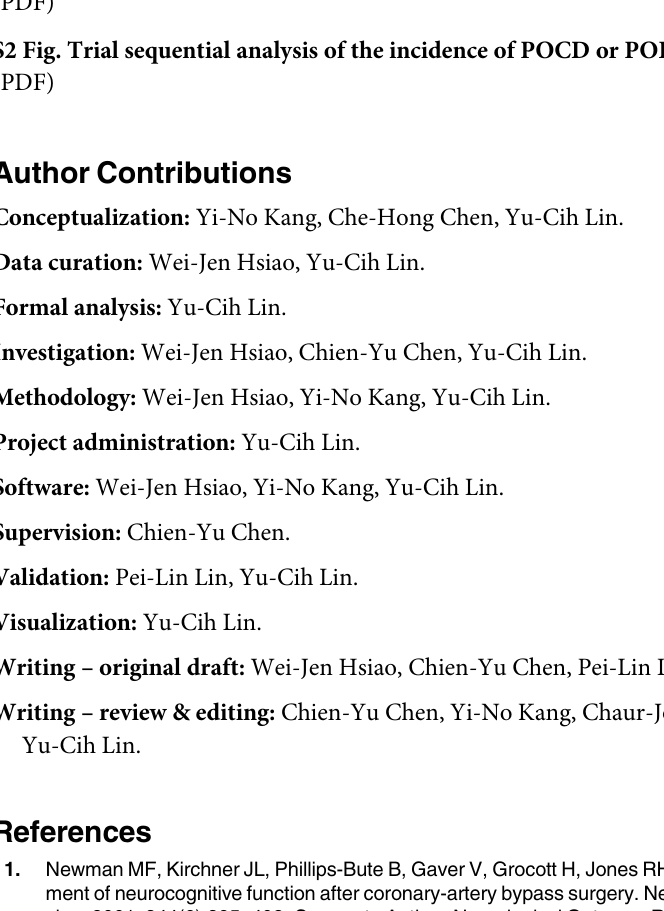
S1 Table. Details of thirty-three full-text studies excluded. S1 Fig. Sensitivity analyses: Effect of different research characteristics on POCD or POD with ApoE4 carriers. S2 Fig. Trial sequential analysis of the incidence of POCD or